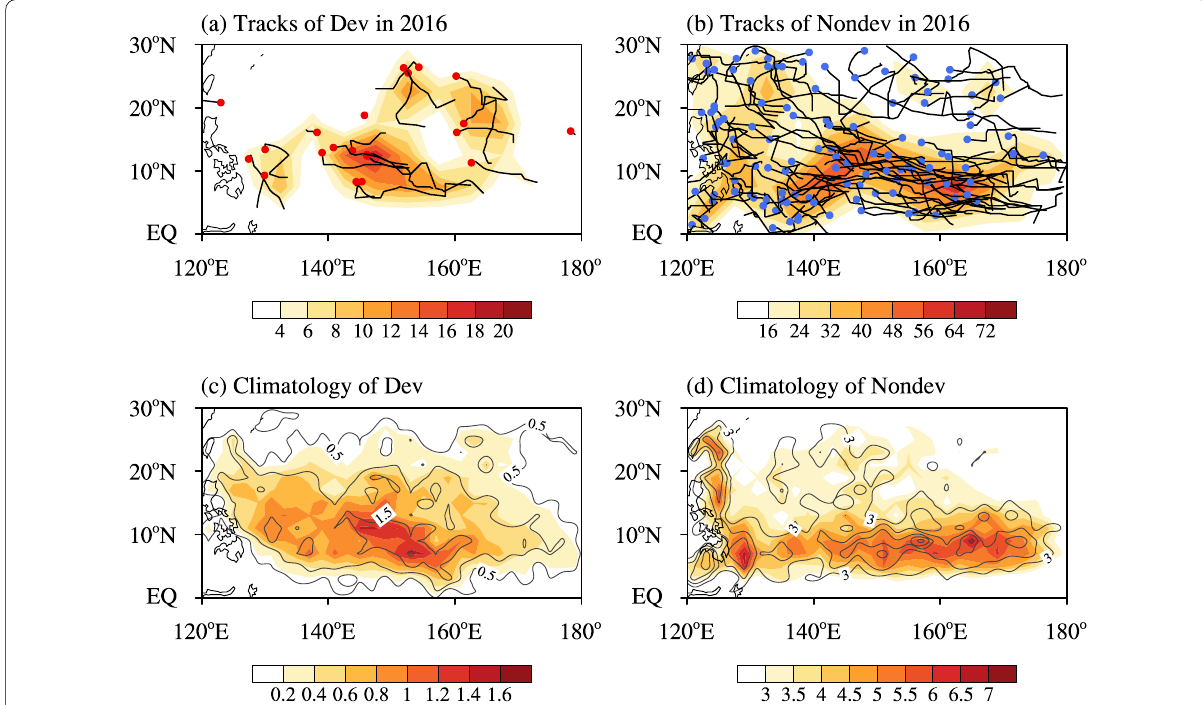
Fig. 2 The tracks of a developing (shaded, in a 5° 5° grid) and b nondeveloping (shaded, in a 5° 5° grid) disturbances in 2016. The filled red × × (blue) dots indicate the location of the developing (nondeveloping) disturbances that develop into TCs (dissipation). Solid lines represent the tracks of tropical disturbances. The composite spatial distribution (shaded, in a 2° 2° grid) and standard deviation (contour) of c developing and d × nondeveloping disturbances over the WNP from June to December of 1965 to 2020. The interval of the standard deviation is from 0.5 (3) to 2.5 (5.5) by 0.5 in c ( d